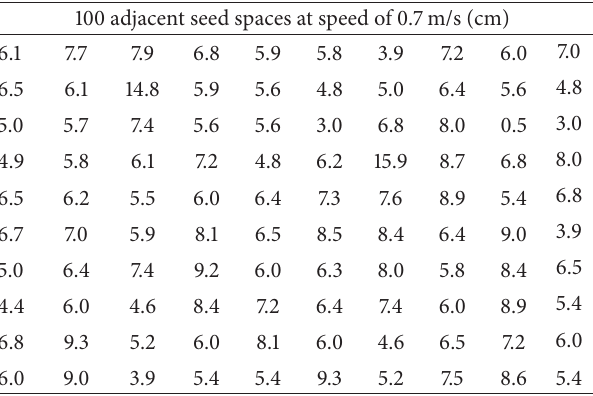
Table 5: Measured data at speed of 0.7m/s.